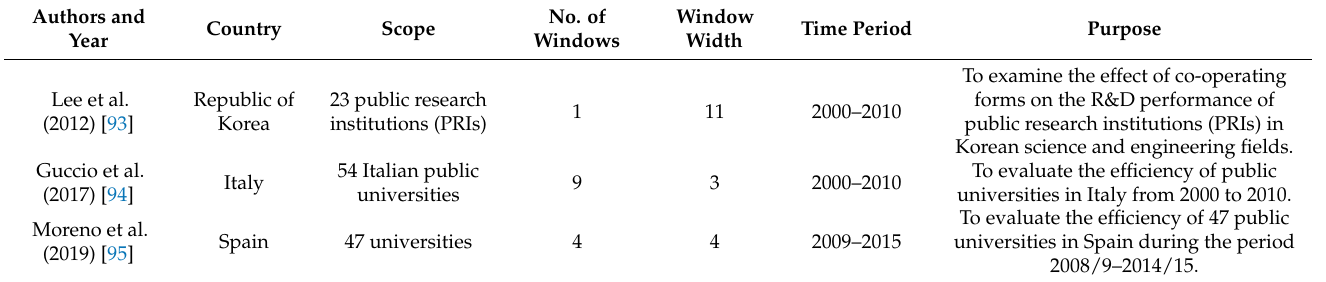
Table 11. Articles classified under the education category.